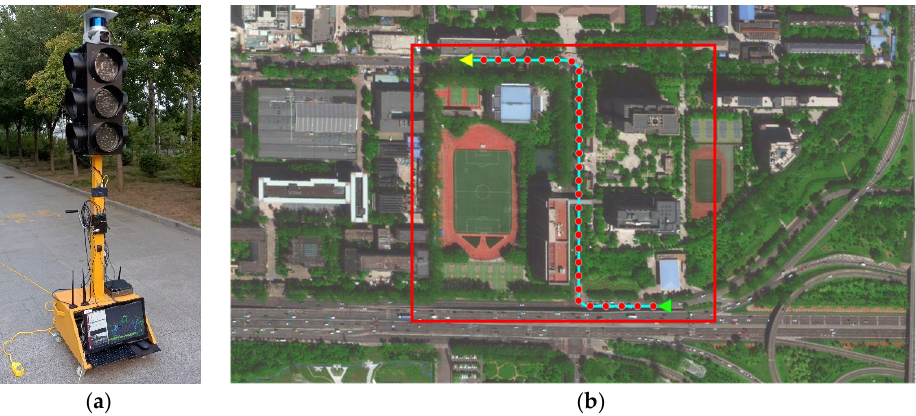
Figure 8. Experimental scenarios and equipment. ( a ) Roadside unit; ( b ) experimental scenarios.